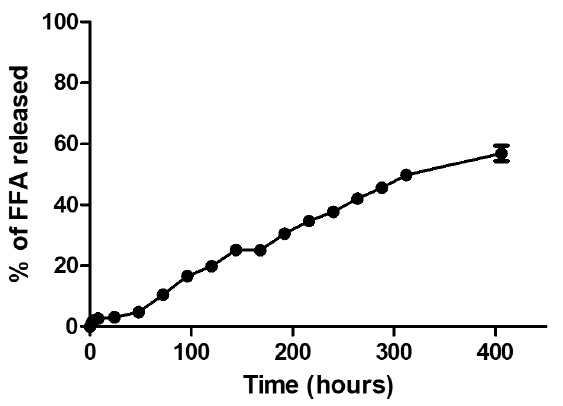
Figure 9. Release profiles of FFA from MCM-41.